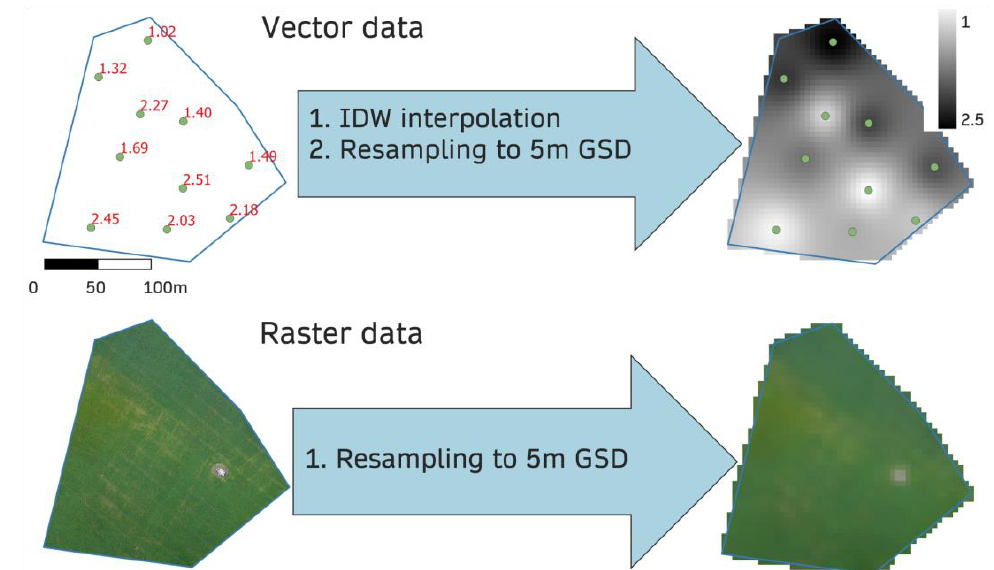
Figure 4. Data preprocessing process of soil (point vector data) and drone orthomosaic (raster data) data. IDW = inverse distance weighting, GSD = ground sample distance (pixel size on the ground).